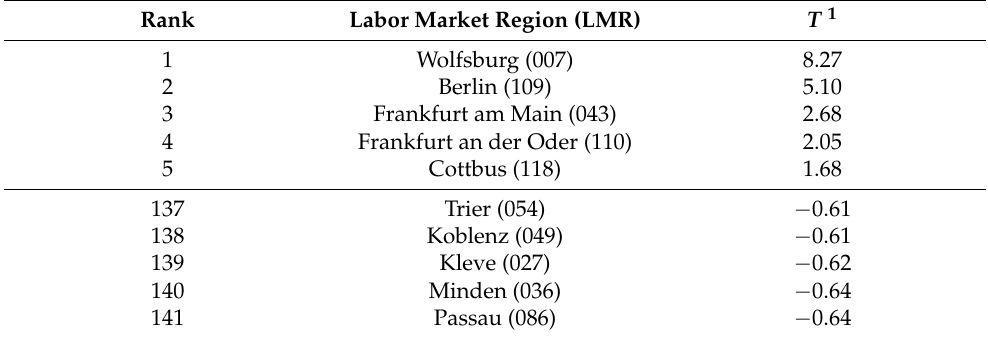
Table 1. Highest and lowest ranked labor market regions based on 2007 tightness values T .